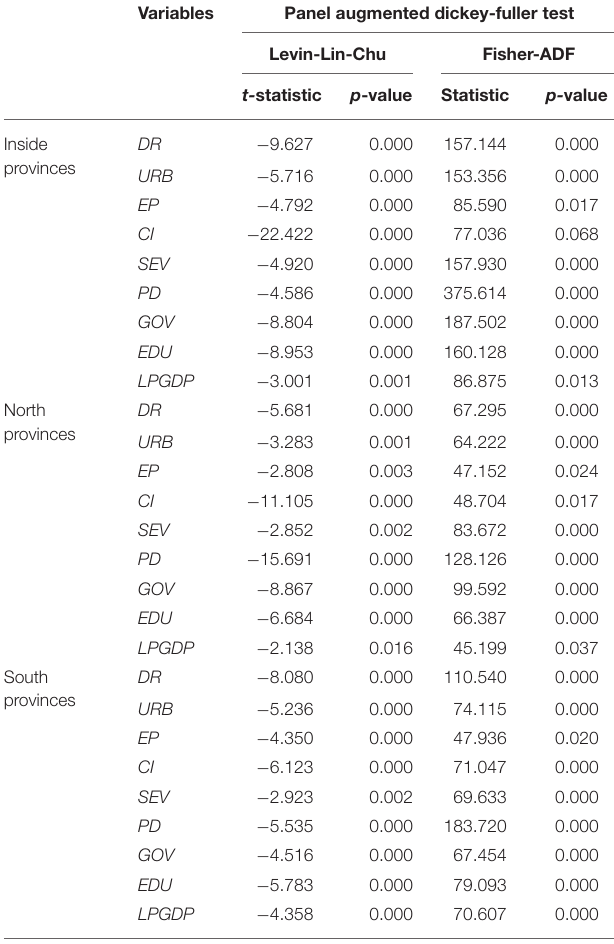
TABLE 2 | Panel unit root